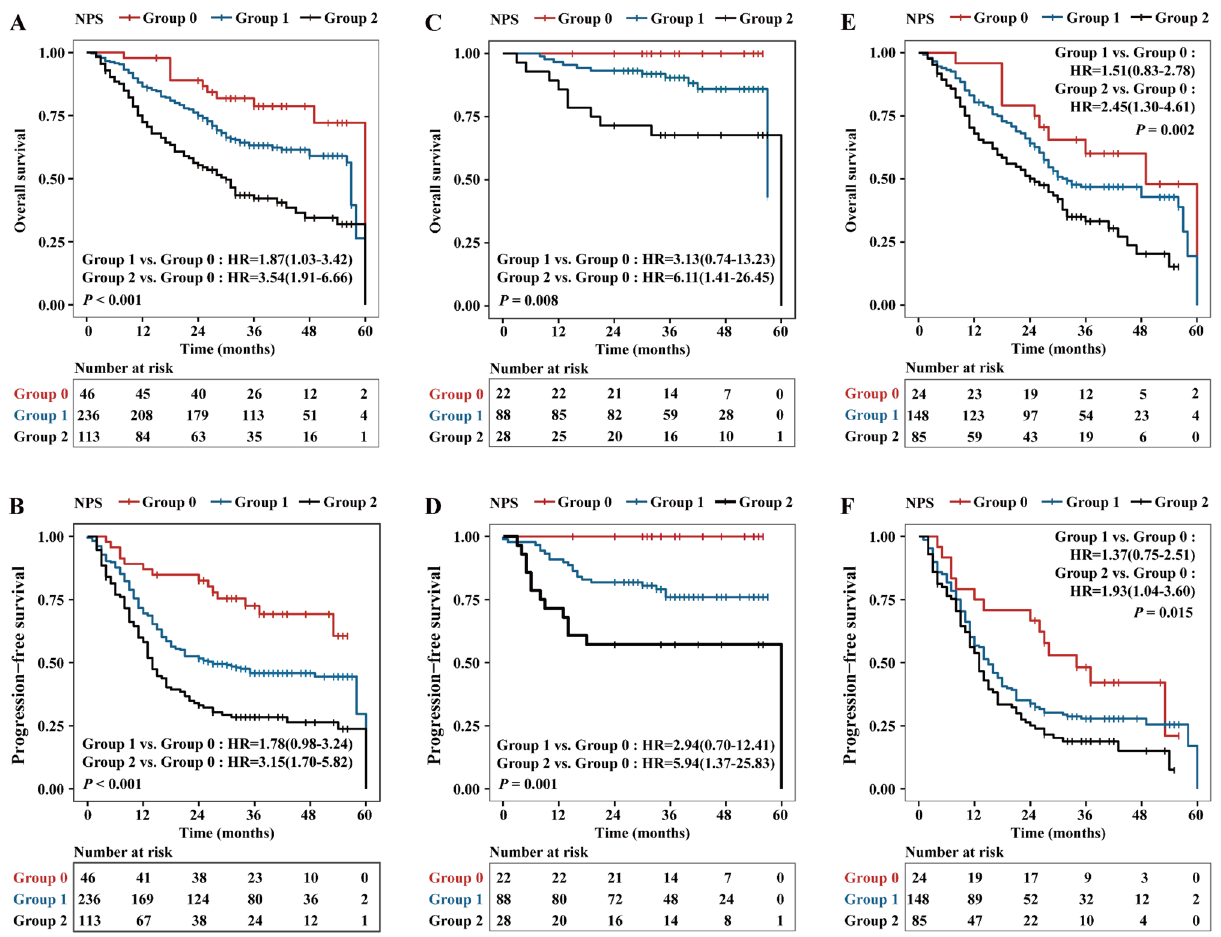
Figure 1. Kaplan–Meier survival curves of Naples prognostic score (NPS) in NSCLC patients. ( A ) Overall survival (OS) in all patients. ( B ) Progression-free survival (PFS) in all patients. ( C ) OS in stage I–IIIA. ( D )